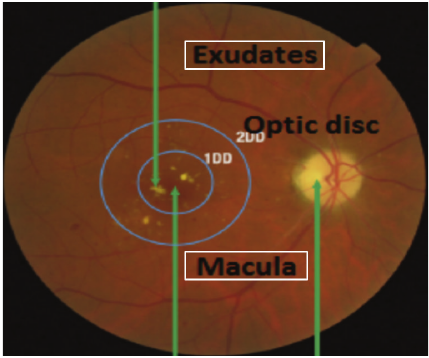
Figure 5: Macula exudates and optic disc in fundus image.